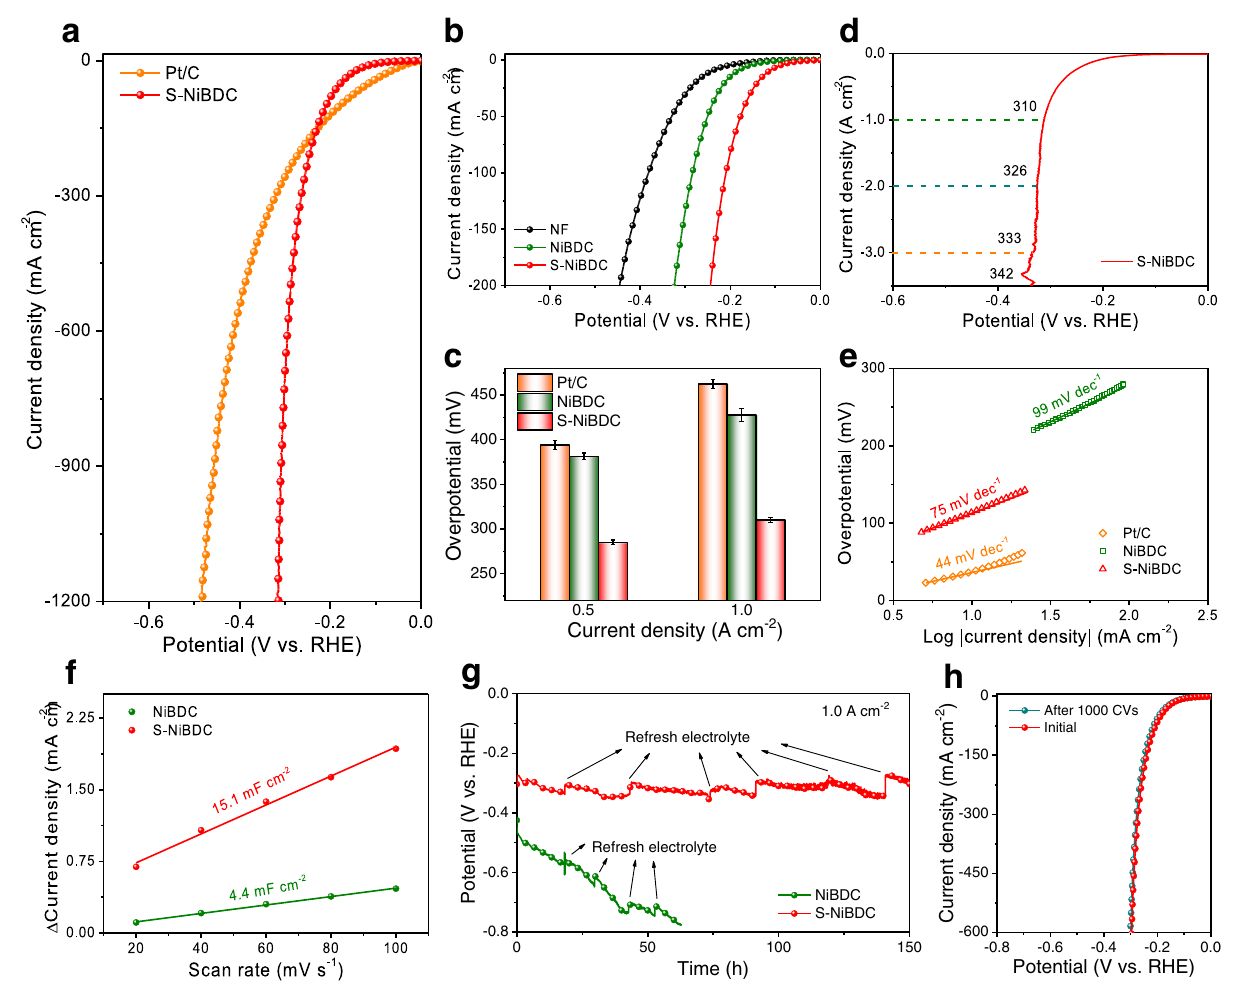
Fig. 3 | Electrocatalytic HER performance. a Polarization curves of S-NiBDC and Pt/C. b Polarization curves of NiBDC, S-NiBDC, and NF. c Overpotentials at 0.5 and 1.0Acm − 2 of NiBDC, S-NiBDC, and Pt/C. Error bars correspond to the standard deviation of the three measurements. d Polarization curve of S-NiBDC at